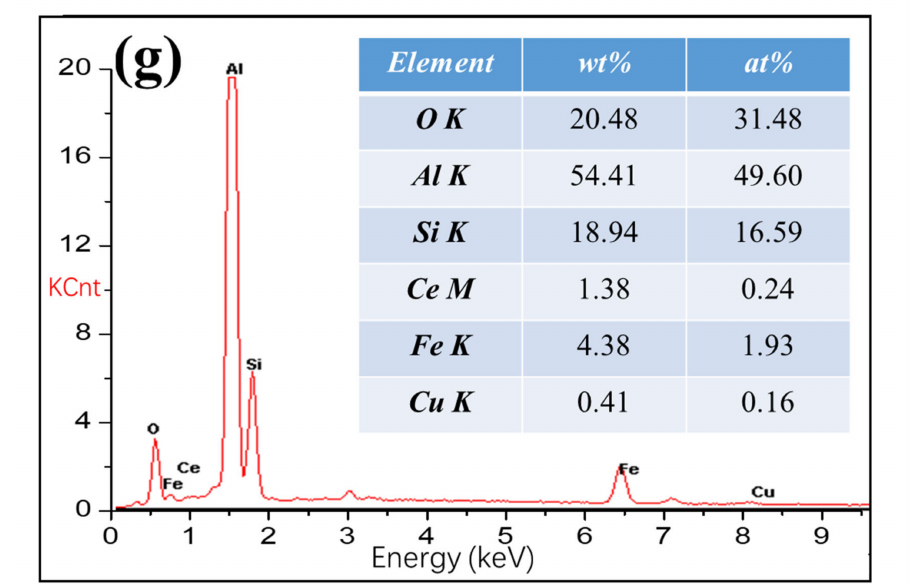
Figure 9. The SEM and EDS pictures of wear surface morphologies of SiCp / Al-Si composites with di ff erent CeO 2 contents: ( a ) 0; ( b ) 0.15 wt%; ( c ) 0.30 wt%; ( d ) 0.60 wt%; ( e ) 1.20 wt%; ( f ) 1.80 wt%; ( g ) the energy spectrum diagram of point A in Figure 9f.